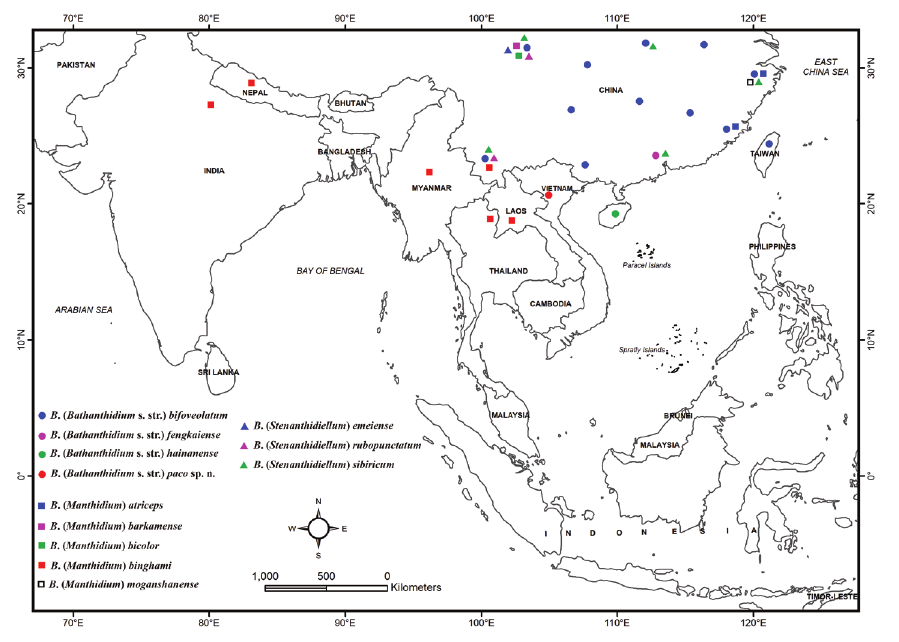
Figure 4. Distribution map of Bathanthidium species in the Indomalayan